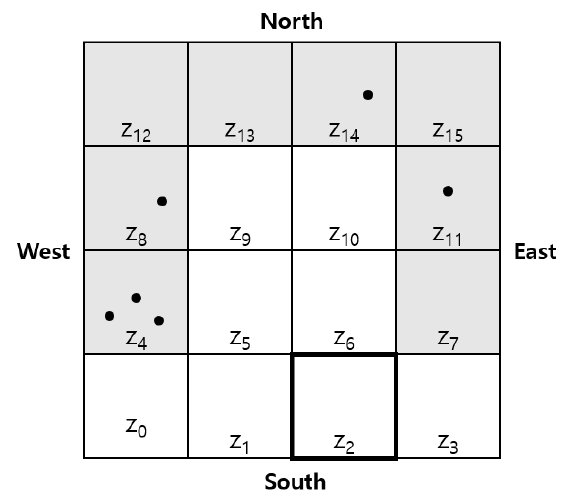
Figure 5. An example of waypoints in the border zone of z 2